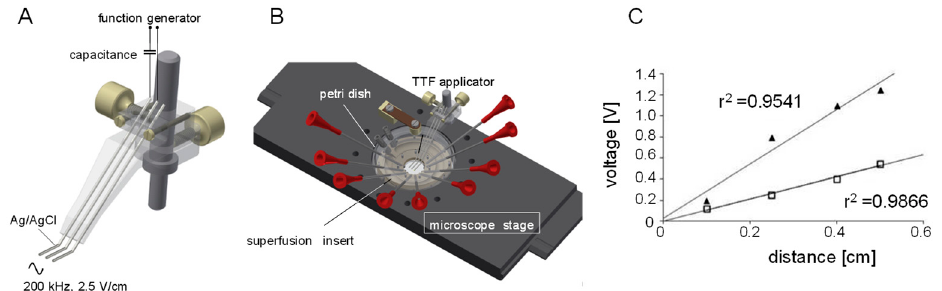
Figure 1. Single cell TTFields applicator. ( A ) Drawing of the applicator. TTFields are applied conductively by two Ag/AgCl electrodes connected via a capacitance (to avoid flow of offset direct current) to a function generator (3rd electrode was originally designed for a parallel real-time 0 V/cm-field strength control but not used). ( B ) Positioning of the TTFields applicator, Petri dish, and superfusion/heating insert at the stage of an inverted microscope. TTFields application and cell recording were performed at 37 °C during continuous superfusion with bath solution. Field strength in the bath solution between both application electrodes at the dish bottom was controlled by the use of two Ag/AgCl recording electrodes. ( C ) Recorded voltages (peak to peak) within the TTFields at different distances. TTFields field strength was adjusted to 2.5 V/cm (closed triangles) and 1 V/cm (open squares) in NaCl solution, respectively. Recorded voltages were fitted by linear regression. The obtained correlation coefficients (r 2 ) were r 2 > 0.9 suggesting a homogeneous distribution of the alternating electric fields between the applicator electrodes.